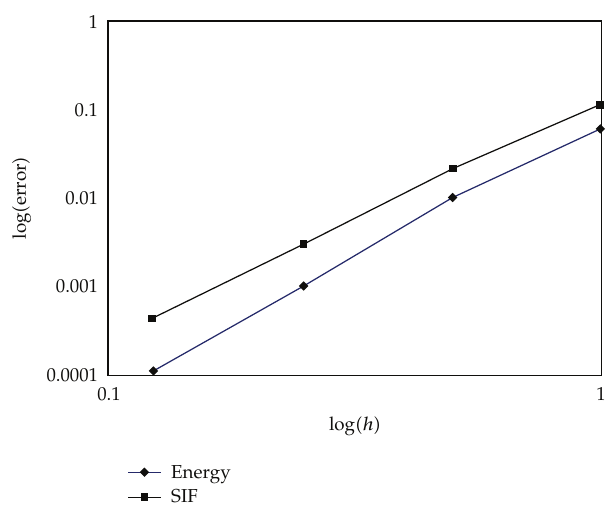
Figure 11: The change of the stress intensity factor and the error in the energy for di ff erent element sizes (cid:5) h (cid:6) at the macroscopic scale.